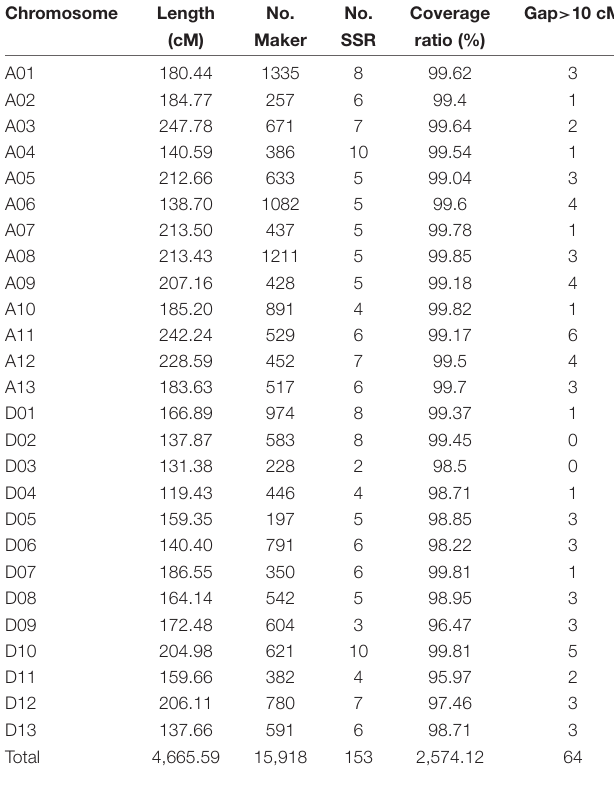
TABLE 1 | Detailed information of the high-density genetic linkage